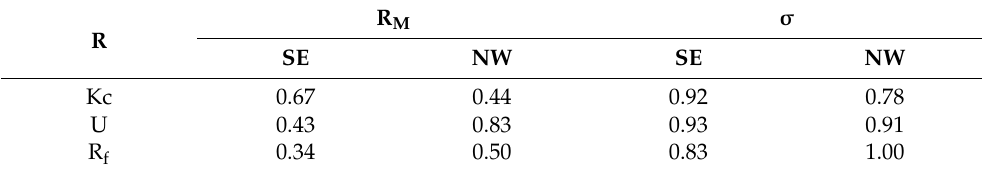
Table 12. The Pearson correlation.